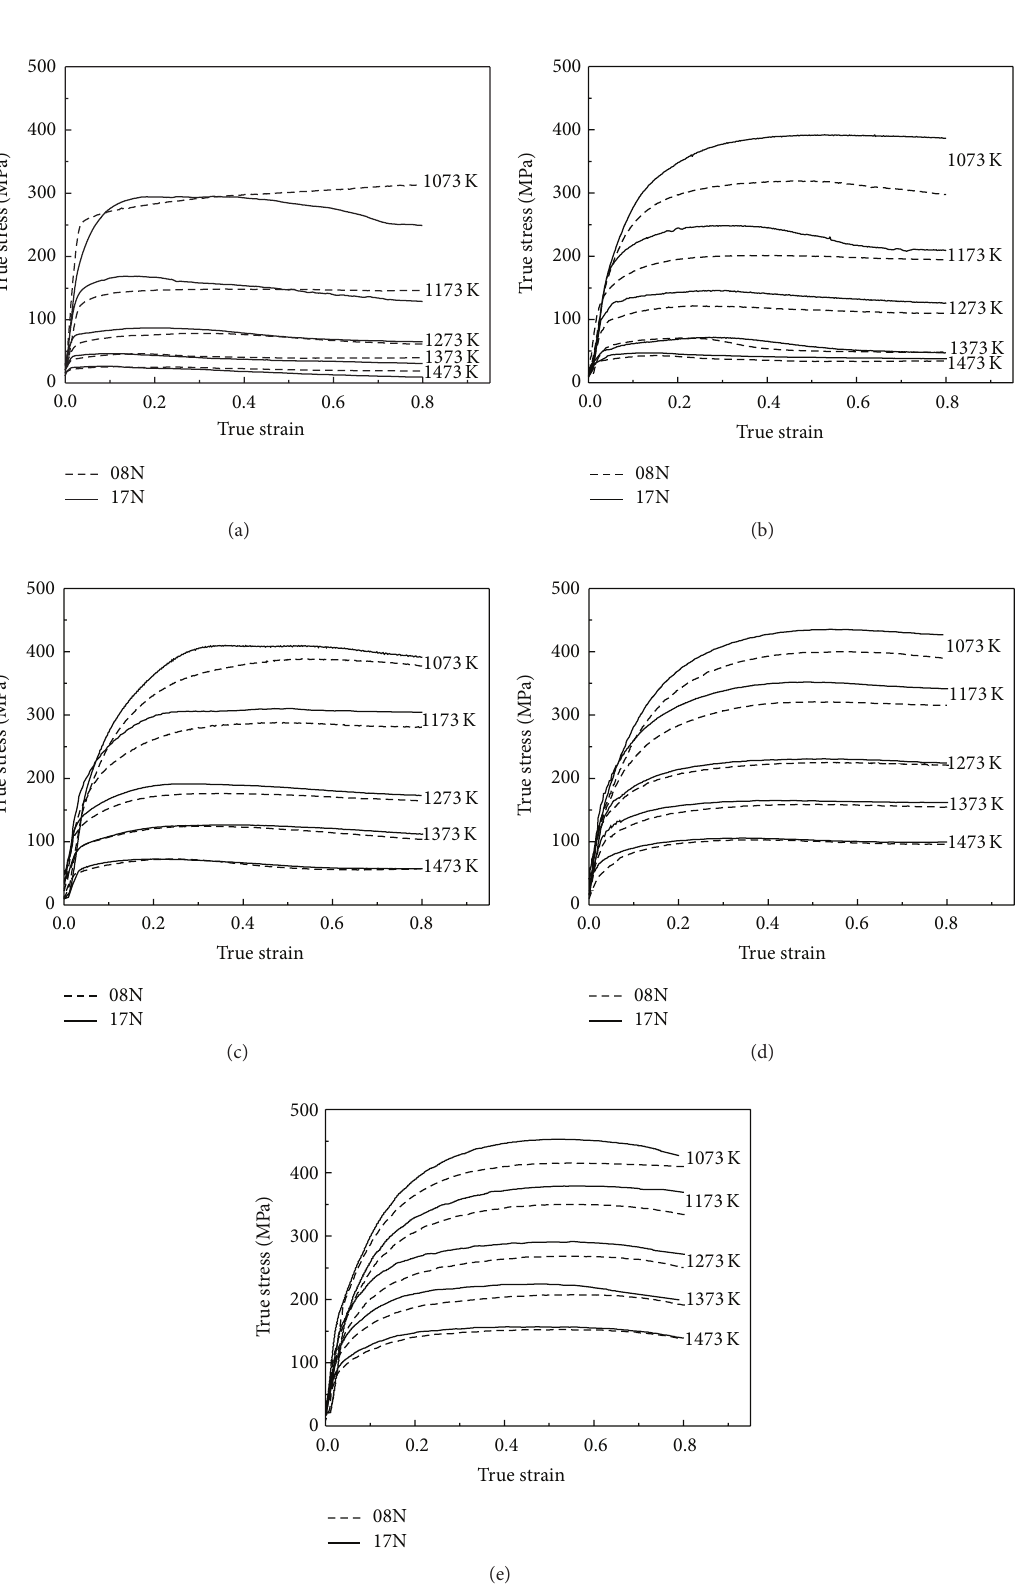
Figure 1: Flow curves of 316LN steel with different N content deformed at different strain rates: (a) 0.001 s −1 , (b) 0.01 s −1 , (c) 0.1s −1 , (d) 1s −1 , and (e) 10s −1